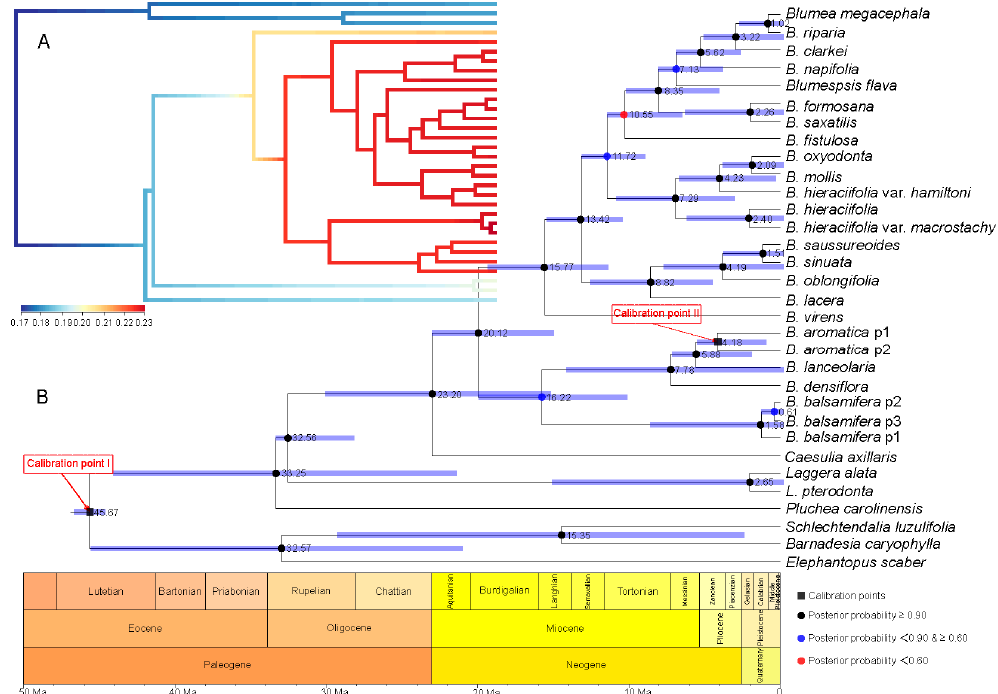
Figure 4. Divergence time estimation and speciation ‒ extinction rate analysis based on the root age of Asteraceae as 49–42 Ma [20–22] and combined sequence. ( A ) The speciation ‒ extinction rates analysis performed by BAMM [23] and BAMMtools [24]. ( B ) The divergence time estimation performed by BEAST 1.10.4 [25], and geological time scale visualized with the strap package [26]. The values beside nodes indicate the estimated median time of differentiation, and error bars indicate 95% highest posterior density (HPD) of differentiation. The black squares on nodes indicate calibration time. The circles with black, blue and red respectively indicate posterior probability more than 0.90, 0.60-0.90, and less than 0.60.